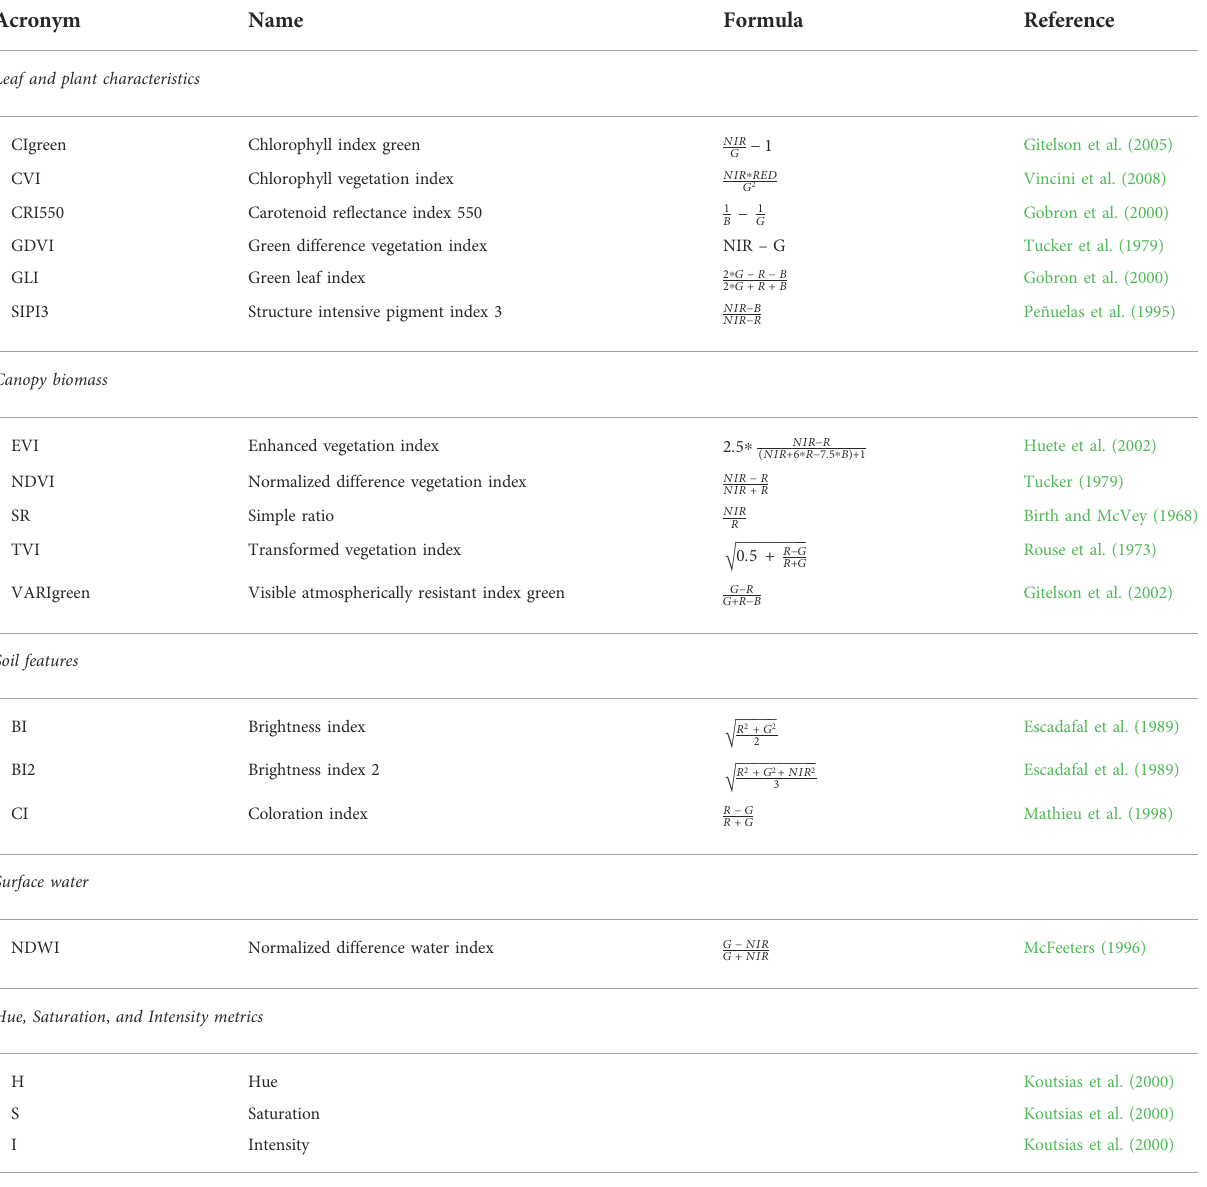
TABLE 1Computed spectralindices andmetrics: acronyms, fullnames,formulas,andreferences.Concerningthe spectral indicesaregrouped bythe main biophysical parameters related to leaf and plant characteristics, canopy biomass, soil features, and surface water (see for details Supplementary Material